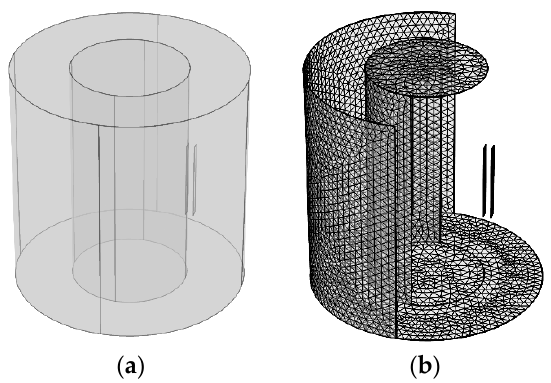
Figure 6. ( a ) Structure of the model, and ( b ) a mesh of the simulation model.